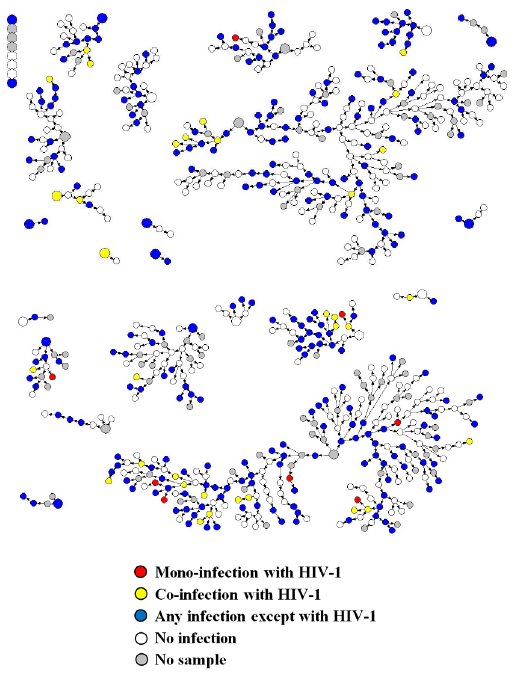
Figure 1. Recruitment network indicated by the presence of HIV-1 mono- infection (red circle), HIV-1 co-infections (yellow circles) and any other infection (blue color).